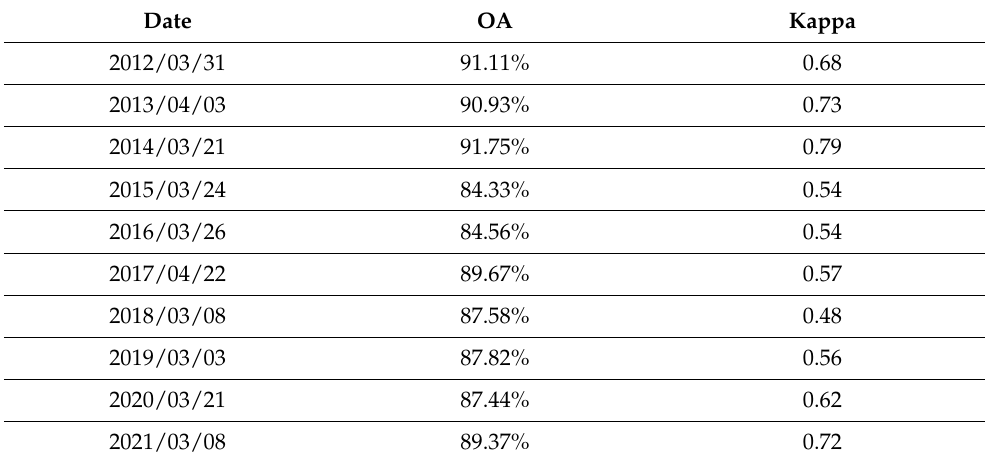
Table 4. Support vector machine classification accuracy